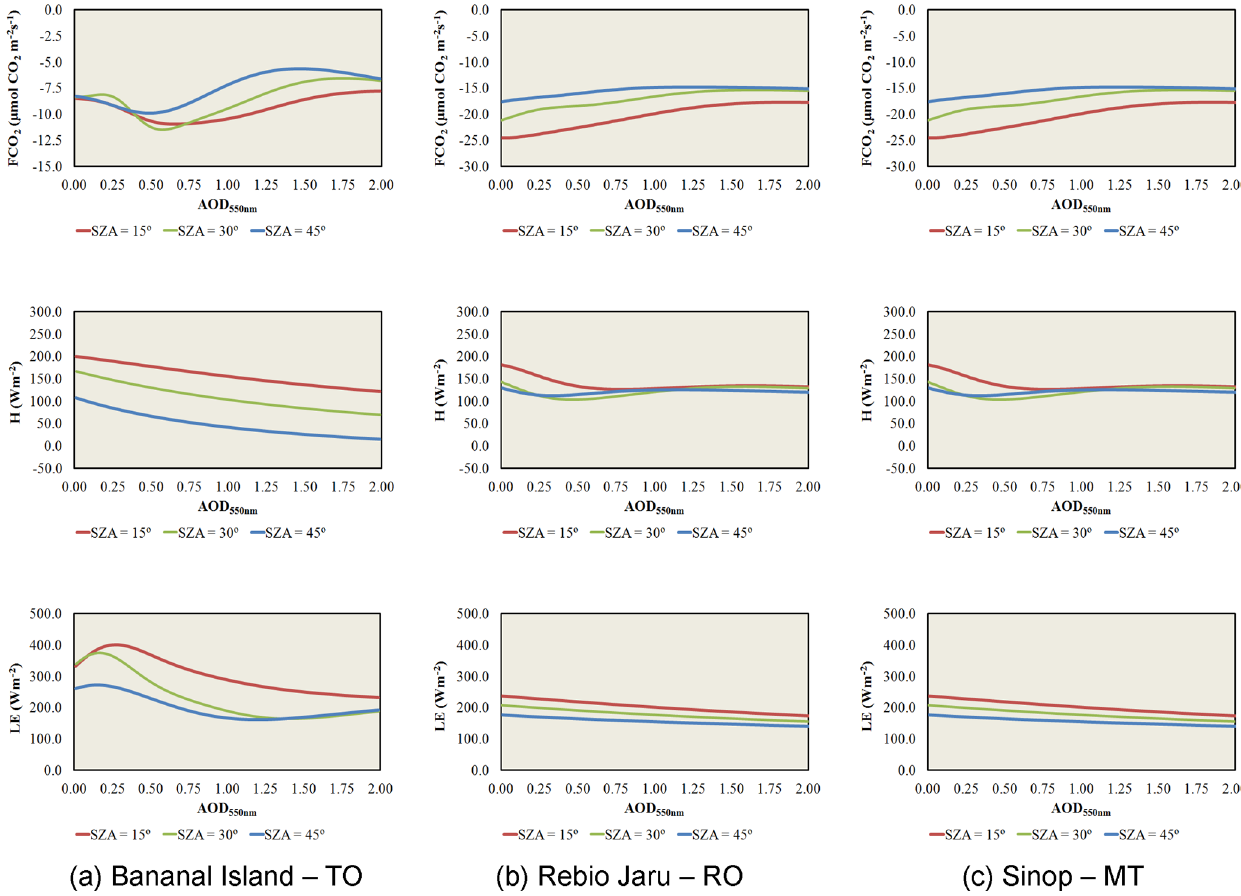
Figure 5. Modeled FCO 2 (µmolCO 2 m − 2 s − 1 ), H (Wm − 2 ), and LE (Wm − 2 ) via ANNs versus AOD 550 nm for three SZAs (15, 30, and 45 ◦ ) for three study sites. Values of temperature, VPD, and u ∗ were kept constant. PAR i and PAR dif were obtained through